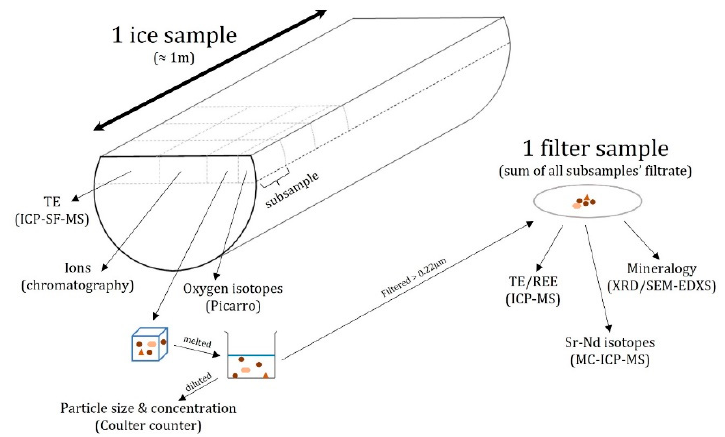
Figure A1. Simplified visual stratigraphy of the deepest 45 m of the GP ice core. Horizontal bars in the sketch mark the location of diffuse brown or greenish dust layers. Dots of various sizes symbolize dust particles and nodules. The grey dust nodules are larger within the deepest 5 m of the core. Note that the size of particles and nodules is not at scale in the sketch. The arrows point to the top depth of the 6 deepest 1 m ice sections discussed in this paper. The color difference is still noticeable among dust filters, as shown here in small photos of T292 and T308 filters. Photos of deep ice core sections show the grey nodules (T311, left) and horizontal diffuse layers (T312, right). Bubbles are present throughout the core and extend all the way to the bedrock, confirming the ice’s meteoritic nature. The nodules’ increasing size with depth could reflect growth by aggregation with time [60]. core, which are not discussed in this paper.